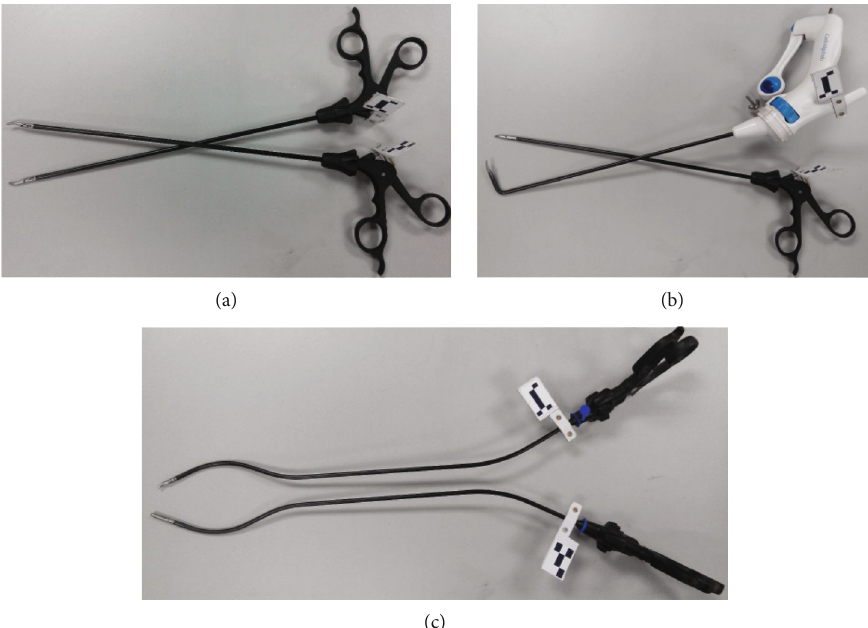
Figure 2: Location of the marks in the instruments. (a) Straight instruments. (b) Straight and articulating instruments. (c) Precurved instruments.